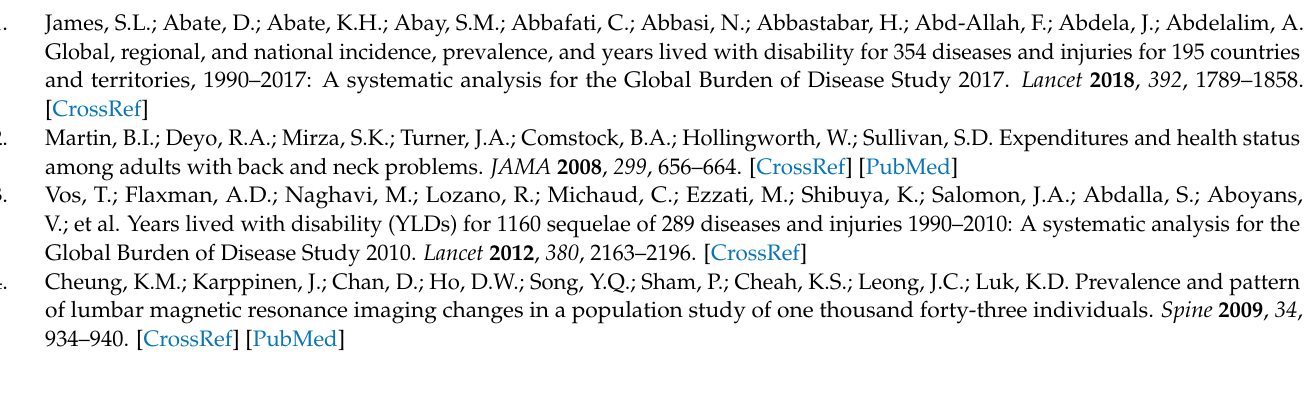
BMSCs; Figure S4: Luciferase expression of BMSCs transduced with Bac-Luc2 and Bac-L-Luc2/Bac- Cre, compared with mock transduction; Figure S5: BMSCs mor-phology after recombinant BV transduction; Figure S6: Intact coccygeal disc H&E